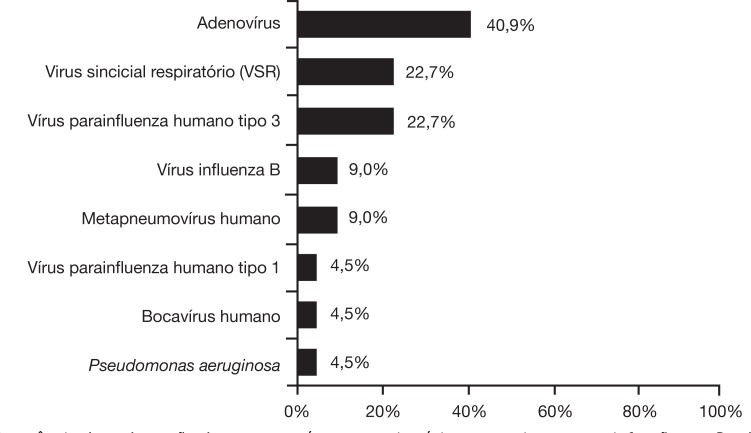
Frequência de codetecção de outros patógenos respiratórios em pacientes
com infecção por Bordetella pertussis.